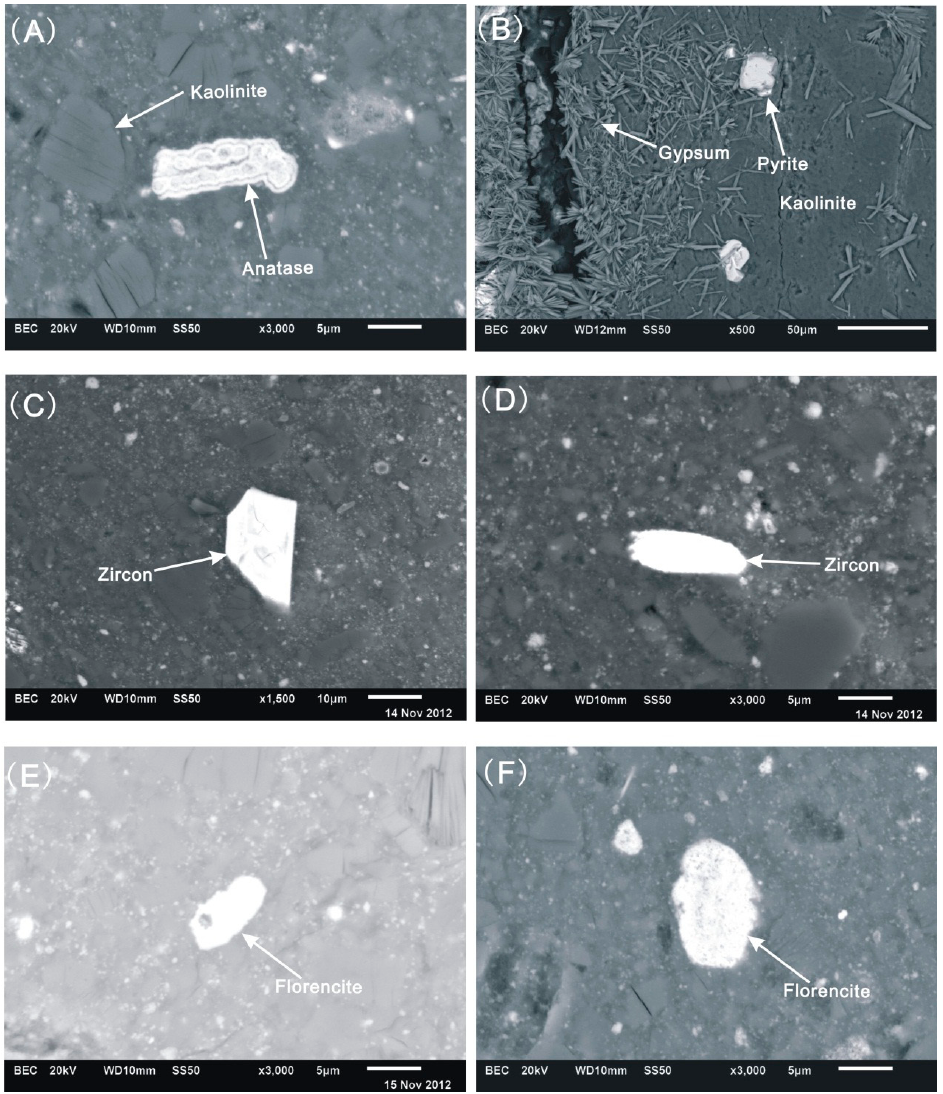
Figure 5. Back scattered images of minerals in the Zhongliangshan tuff: ( A ) kaolinite and anatase in sample S140SE7-4; ( B ) gypsum, pyrite, and kaolinite in sample S140SE7-10; ( C ) zircon in sample S140SE7-15; ( D ) zircon in the sample S140SE7-15; ( E ) florencite in sample S140SE7-21; and ( F ) florencite in sample S140SE7-4.